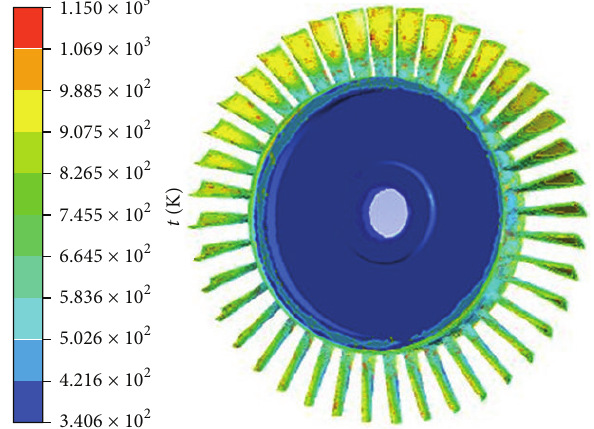
Figure 6: Temperature distribution of blisk surface.